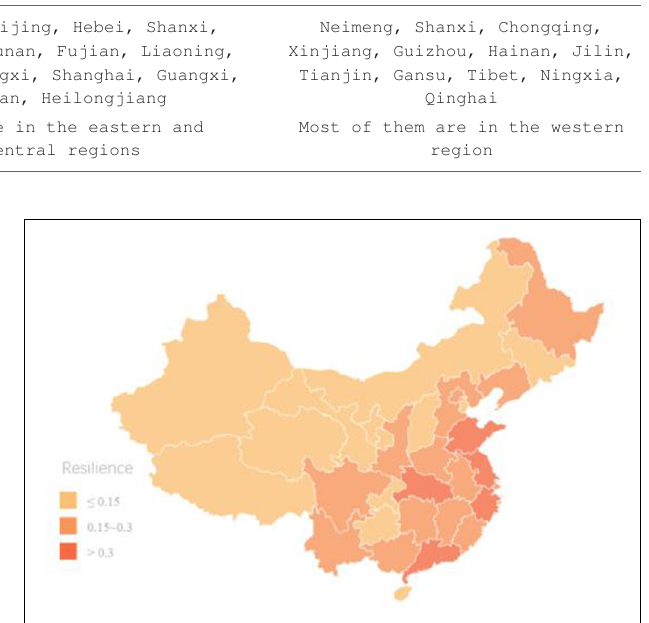
TABLE 3 | Clustering of average scores based on the integral development resilience assessment. Scores The first level (Average Score ≥ 0.3) Region